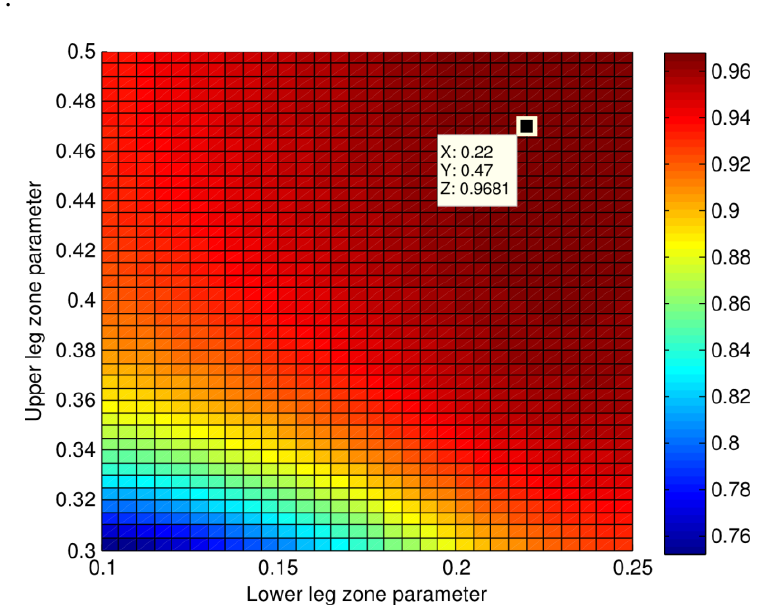
Figure 6. Correlation coefficient between the longitudinal asymmetry index computed from raw depth information with our method and the reference longitudinal asymmetry index computed from motion capture information. The lower leg zone parameter was varied from 0.3 H to 0.5 H, and the lower leg zone was varied from 0.1 H to 0.25 H. The maximum correlation coefficient is 0.968, as shown for the upper leg zone at 0.47 H and the lower leg zone at 0.22